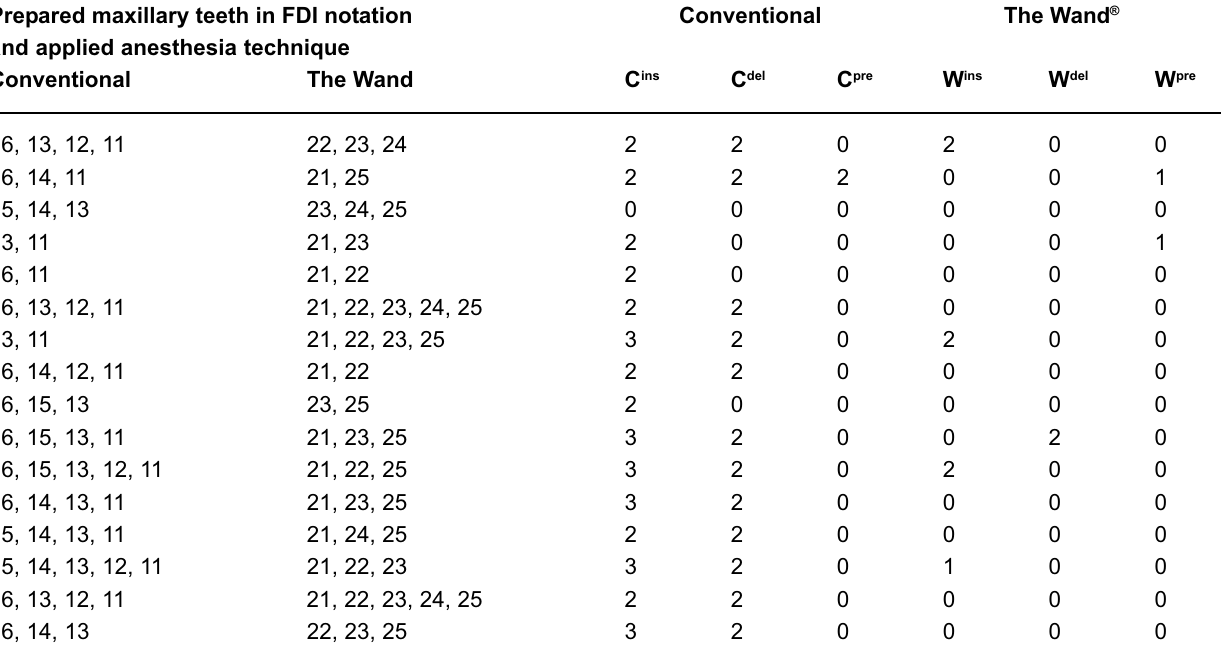
TABLE 1- Prepared teeth of the patients in FDI (Federation of Dental International) notation system and VRS* pain data from conventional and the Wand ® anesthesia